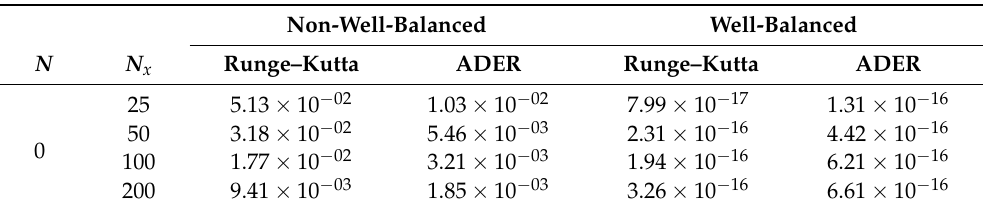
Table 5. Numerical validation of the well-balanced and non well-balanced methods for the stationary problem (61) (Euler equations). Table contains L 1 errors for the density variable ρ at a final time t = 10 s for both Runge–Kutta and ADER DG schemes of order N + 1 = 1, 2, 3, 4. Uniform Castesian meshes of N x elements has been